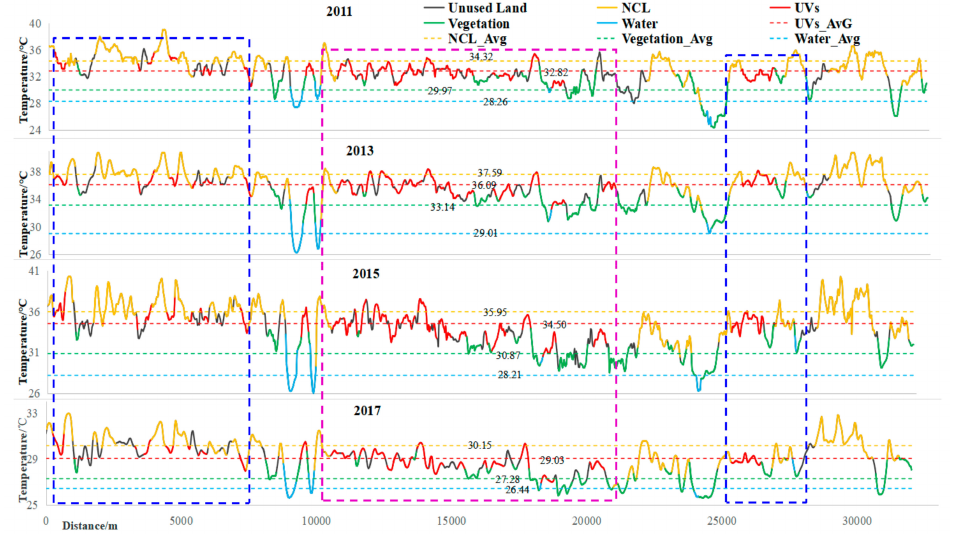
Figure 8. Profile analysis results of Line 1 (NCL_AVG: average surface temperature of normal construction land; UVs_AVG: average surface temperature of UVs; Vegetation_AVG: average surface temperature of vegetation; Water AVG: average surface temperature of